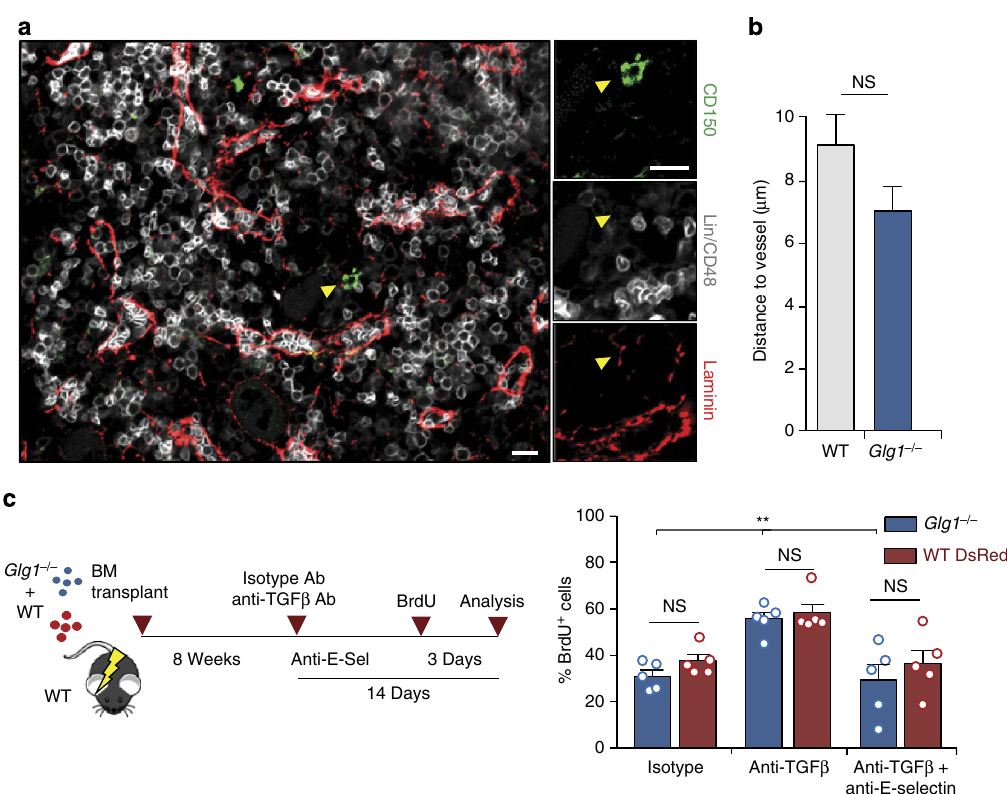
Figure 4 | ESL-1 and E-selectin induce HSPC proliferation through independent mechanisms. ( a ) Representative images of the distribution of Lin NEG CD48 NEG CD150 þ cells in the BM relative to laminin HI (red) vessels; arrowheads indicate the position of a scored cell. Scale bars, 10 m m. n ¼ 7–9 mice, 55–70 cells per group. ( b ) Distances of Lin NEG CD48 NEG CD150 þ cells to vessels in WTor Glg1 (cid:2) / (cid:2) BM. NS, not significant, as determined by Student’s t -test. n ¼ 39 or 40 cell per group. ( c ) Experimental design and percentage of BrdU þ LSK cells from each donor (WT-DsRed or Glg1 (cid:2) / (cid:2) ) in mixed chimeric mice treated with isotype-matched, anti-TGF b alone or anti-TGF b plus anti-E-selectin antibodies. n ¼ 5. Bars show mean ± s.e.m. Each circle represents a mouse. ** P o 0.01 by one-way analysis of variance with Turkey’s test comparing Glg1 (cid:2) / (cid:2) cells across the different groups; NS, not